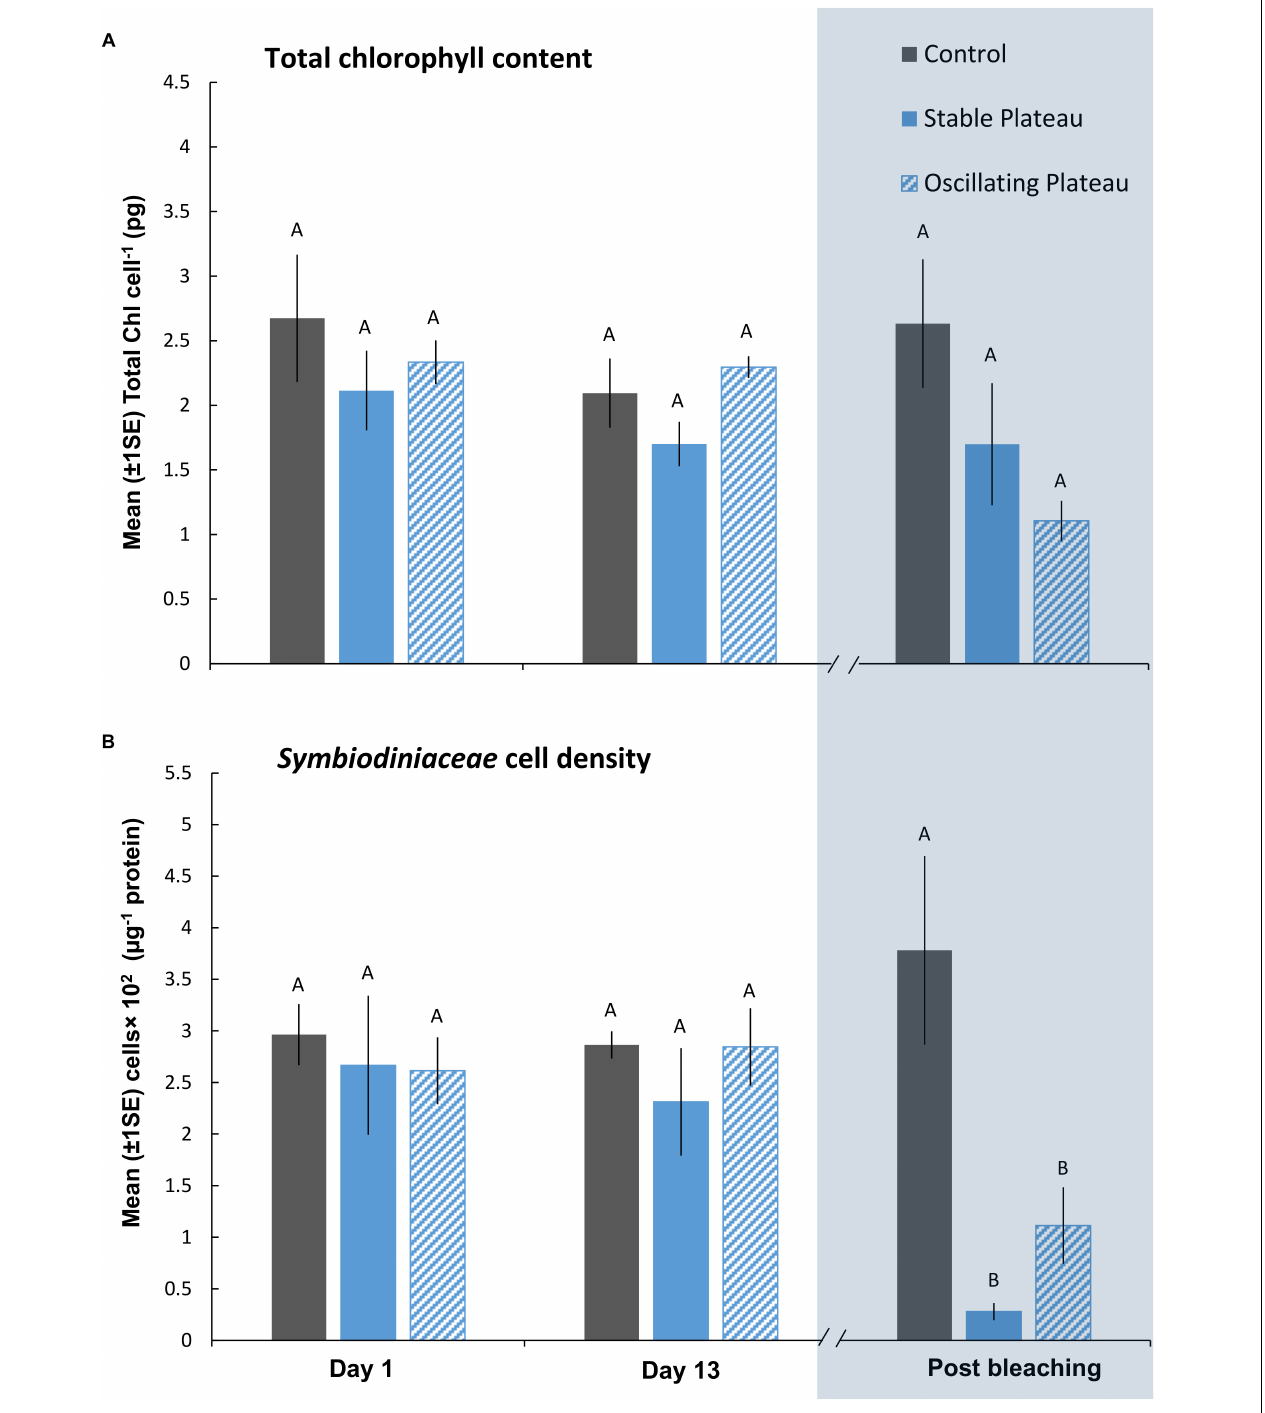
FIGURE 3 | Mean ( ± 1SE) rates of (A) total chl content (pg chl Symbiodiniaceae cell − 1 ) and (B) Symbiodiniaceae cell density ( µ g − 1 total protein) for each treatment (S Plat , O Plat , and Control) in the “Plateau” experiment (Part II) recorded at Day 1, 13, and post-bleaching. Letters next to data points indicate similarities (e.g., AA) or differences (e.g., AB) between the three treatments within each time point, as determined by estimated marginal means post hoc analyses, resulting from analyses reported in Supplementary Tables S4 , S5 . Note; sample sizes vary through time [Day 1 ( n = 5), Day 13 ( n = 3), Post-bleaching ( n = 4) ( n represents number of replicates per treatment)]. Days (and temperatures) at which medusae were sampled post-bleaching (shaded blue) differed, where medusae in the S Plat treatment bleached after 14 days of exposure and medusae in the O Plat treatment bleached after 16 days of exposure (see Figure 1A ).